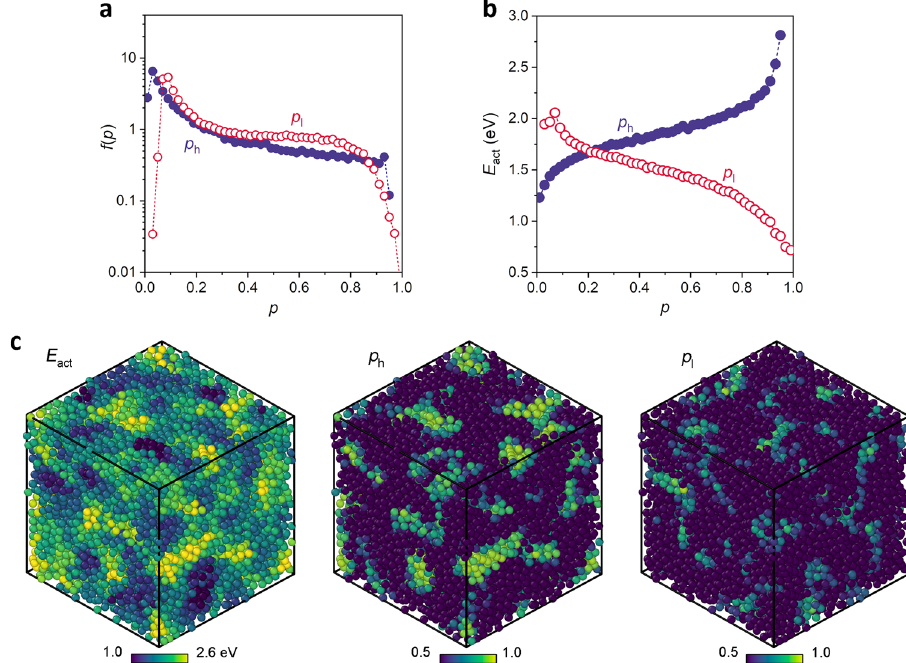
Fig. 3 ML-evaluated class probability. a Probability density distribution, f ( p ), of p h and p l in the combined MG dataset. b Strong dependence of activation energy E act on p h and p l . c Distribution of E act , p h , and p l in a Cu 64 Zr 36 - 10 9 K s − 1 MG. For simplicity, only the atoms with p h or p l > 0.50 are highlighted in c . The high E act and low E act atoms correspond well to the high p h and high p l atoms predicted by